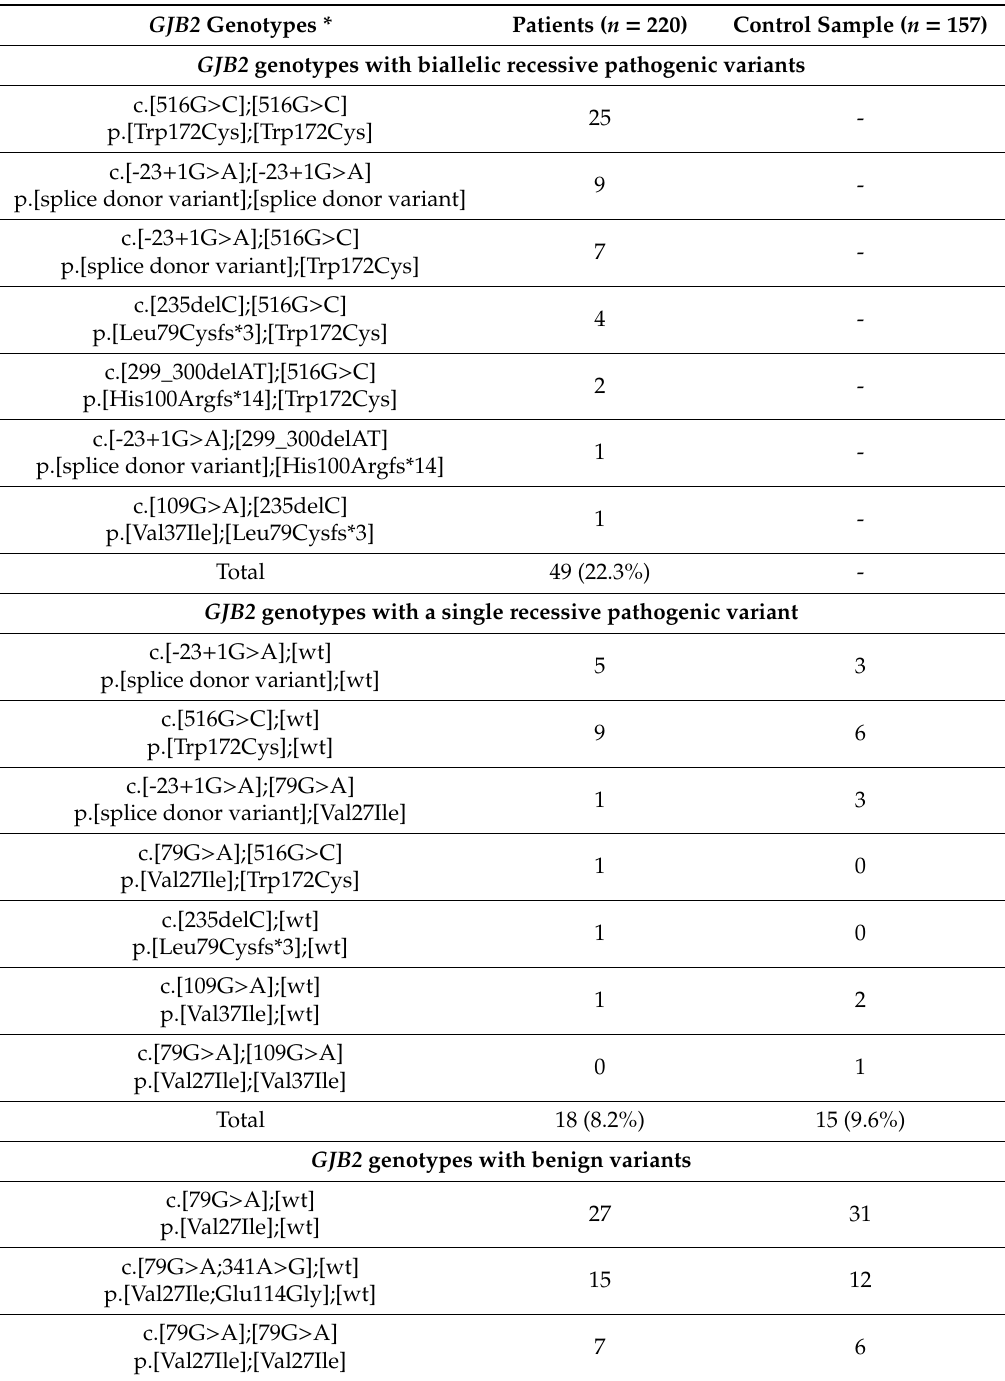
Table 2. The GJB2 genotypes found in Tuvinian patients and control